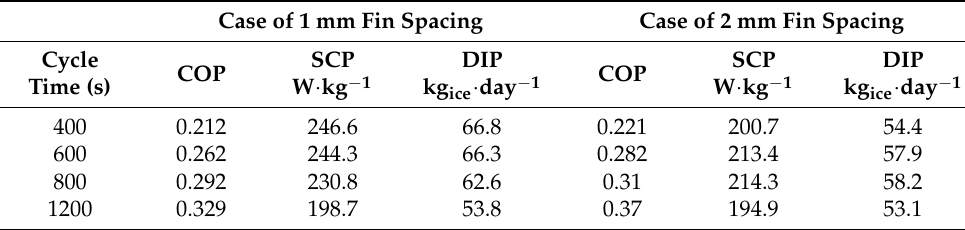
Table 5. The performance indicators of the finned-tube base model at 10 mm fin height. Case of 1 mm Fin Spacing Case of 2 mm Fin